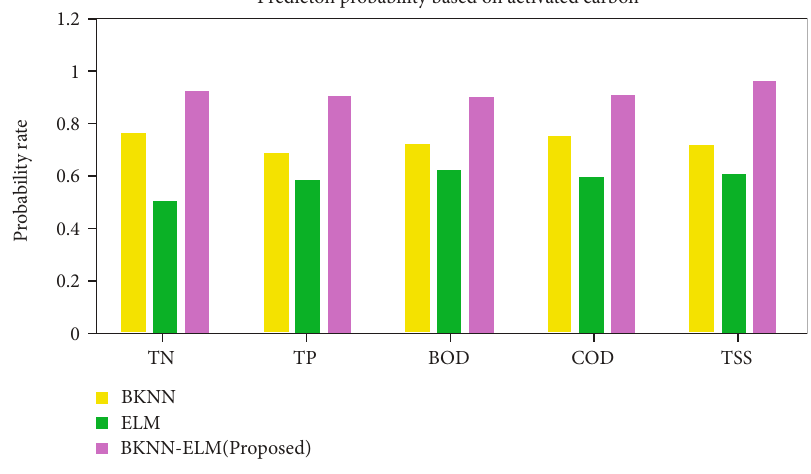
Figure 3: Prediction of in fl uent